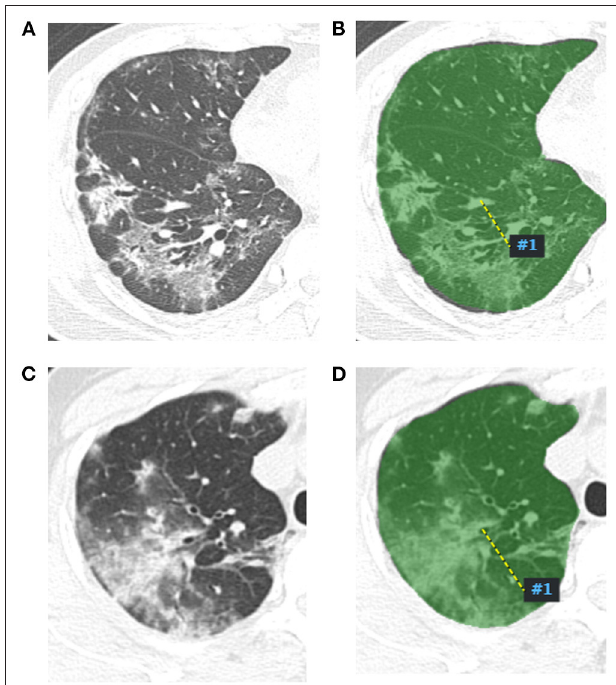
FIGURE 1 | Radiomics features extract map of pneumonia lesion. A two-dimensional image of the largest pneumonia lesion area of a COVID-19 patient in the right lung (A) , the lesion presented as blurred patchy ground glass opacity with little consolidation. The region of interest of the largest pneumonia lesion area was manually delineated in the right lung image, which is displayed as the green area (B) , and artificial intelligence software automatically extracted the radiomics features and output from a computer. A two-dimensional image of the largest pneumonia lesion area of an influenza viral pneumonia patient in the right lung (C) , the lesion presented as ground glass opacity with some consolidation; the CT manifestation was similar with the COVID-19 pneumonia; we used the same method to extract radiomics features from the image (D) .